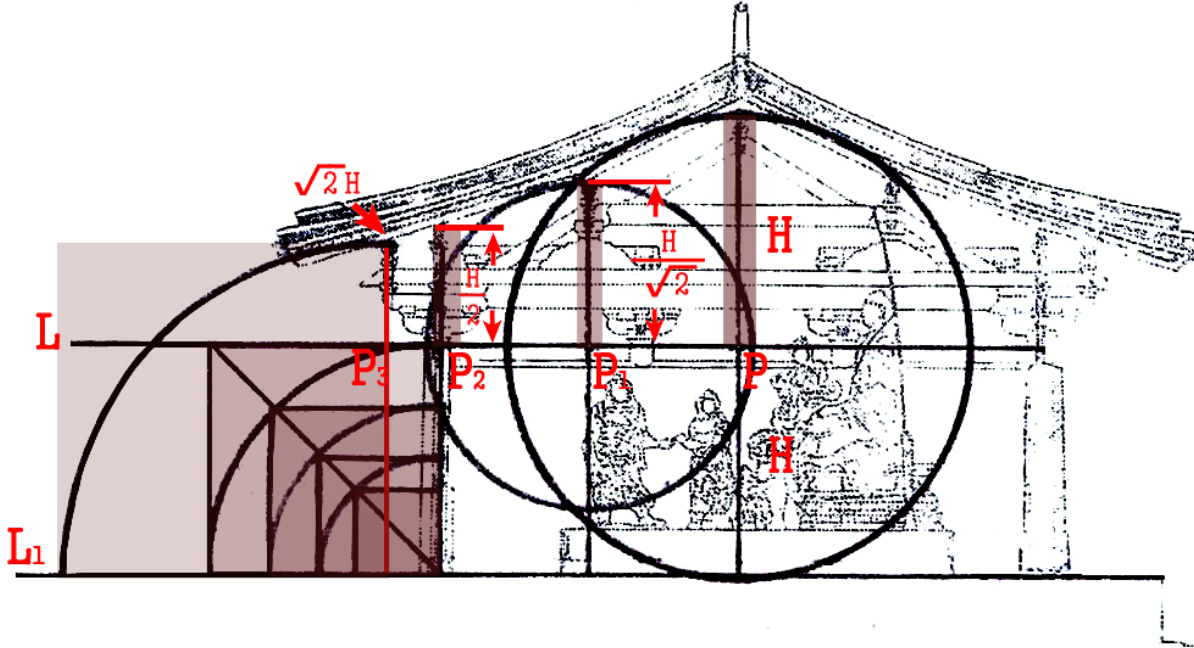
Figure 17. Main Hall of Monastery Nanchansi. Proportional analysis of the sectional elevation (H = eave column height, Ø = circle diameter), Adapted from Wang et al. (2011, p. 143).